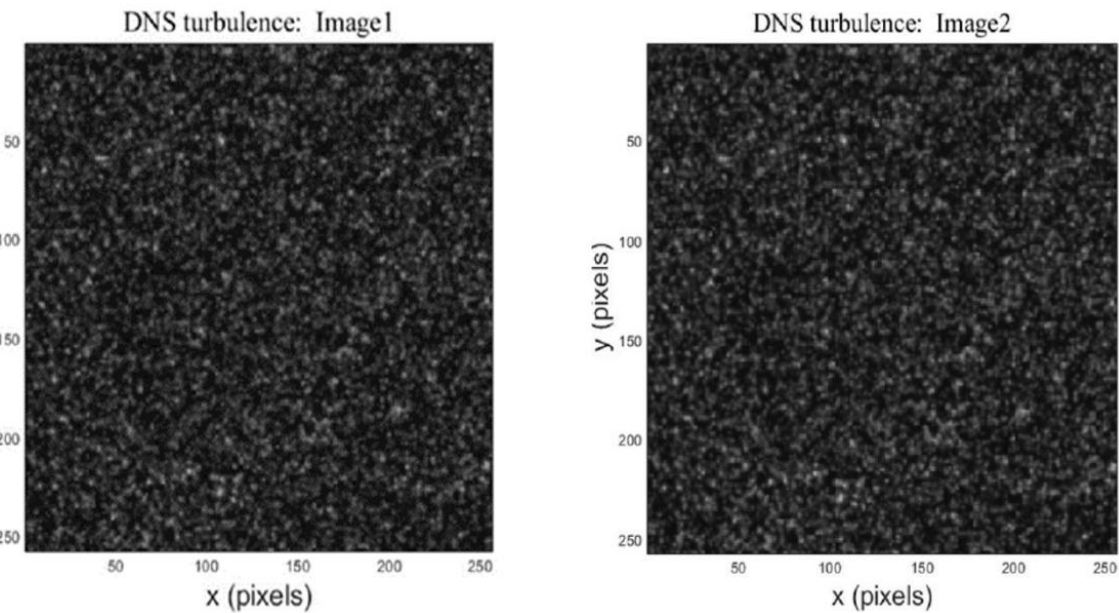
Figure 6. An image pair from DNS-turbulent flow.